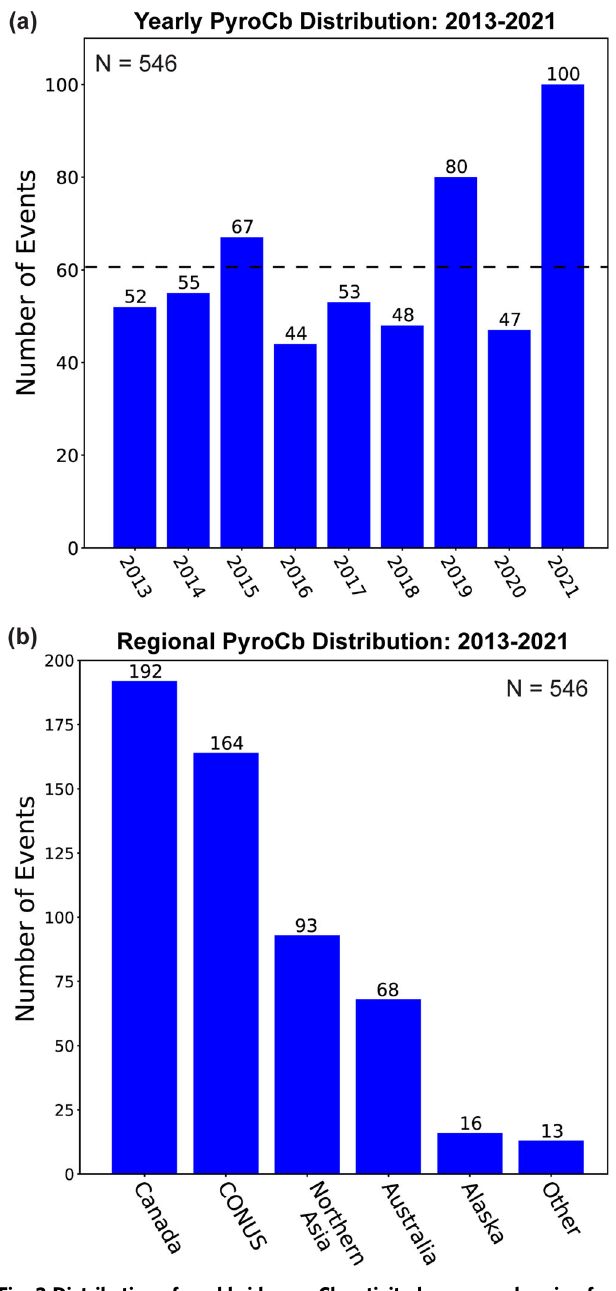
Fig. 2 Distribution of worldwide pyroCb activity by year and region for the period of 2013-2021. Both plots include 546 pyroCb events. The mean yearly pyroCb total (61) is displayed as a dashed line. “ CONUS ” refers to the conterminous USA states. “ Northern Asia ” comprises Russia (Siberia) and Mongolia. These data are part of a worldwide pyroCb inventory developed and maintained by a community 52